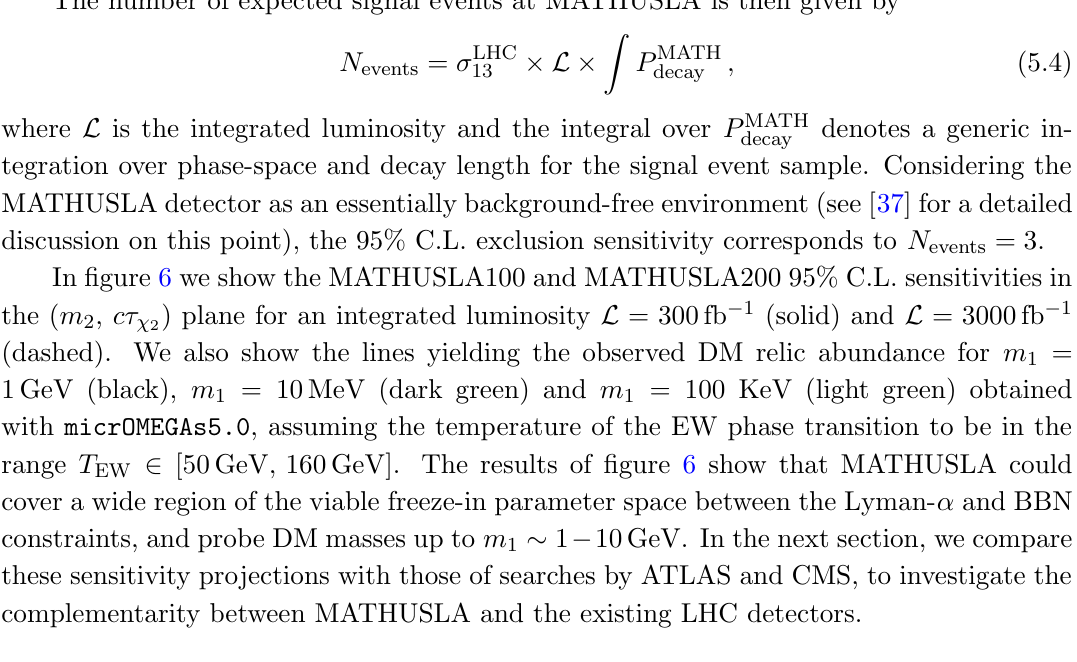
Figure 6 . 95% C.L. exclusion sensitivity (background-free environment assumed, corresponding to N events = 3) for MATHUSLA200 (orange) and MATHUSLA100 (red) in the ( m 2 , c(cid:28) for 300 fb (cid:0) 1 (solid lines) and 3000 fb (cid:0) 1 (dashed lines). Lines yielding the observed DM relic density (cid:10) DM h 2 = 0 : 12 (obtained with micrOMEGAs5.0 ) are shown for m 1 = 1 GeV (black), 10 MeV (dark green), 100 KeV (light green), together with the bounds from BBN (yellow) and Lyman- (cid:11)